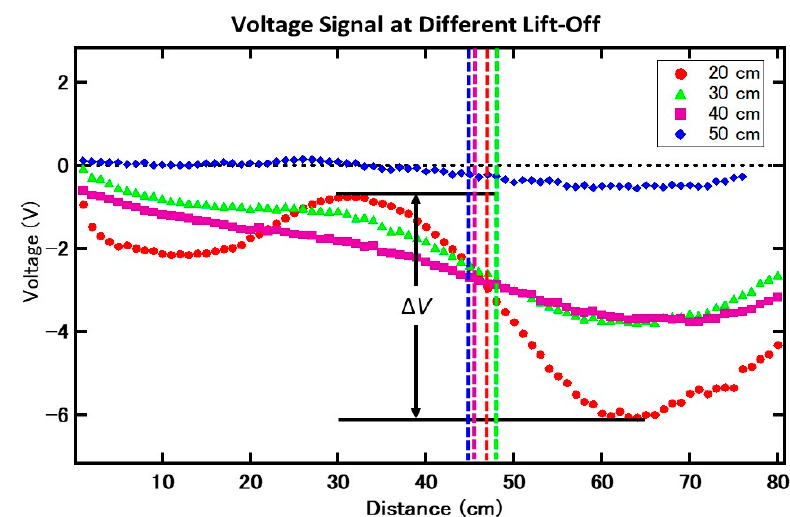
Figure 5. Results of the output voltage signal at each respective voltage. The dotted lines show the estimated defect location at every lift-off, corresponding to their respective graph colors. Δ V is the voltage difference between the highest peak and lowest peak for each measurement.